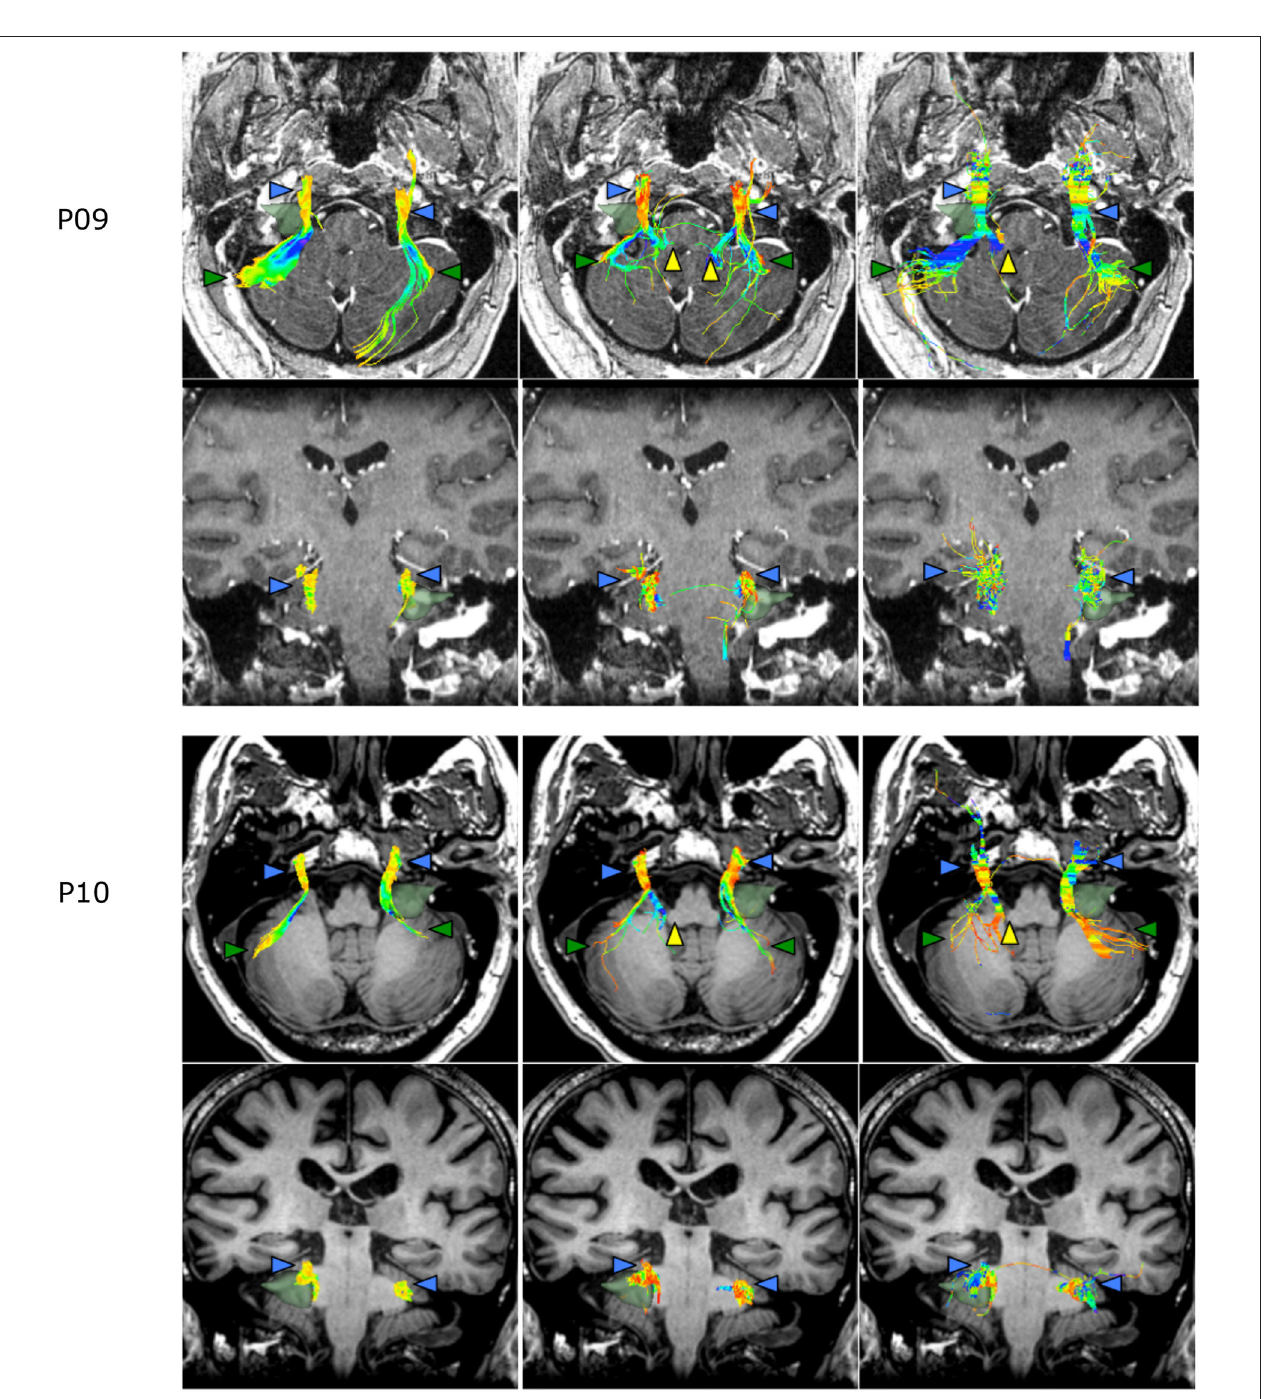
FIGURE 4 | Bilateral CN V generated from each of the three reconstruction methods: Single Diffusion Tensor Tractography (SDT), EXtended Streamline tractography (XST), and streamline tractography on fiber orientation distributions (FODs) derived from constrained spherical deconvolution (CSD) is displayed. Streamlines are displayed overlaid on a T1 anatomical image from a superior and anterior view. Colored triangles indicate particular anatomical landmarks: blue indicates cranial nerves, green indicates superior cerebellar fibers, yellow indicates trigeminal brainstem nuclei. While SDT produced good representations of cisternal segements of CN V (P05–SDT), it was unable to display projections to trigeminal brainstem nuclei (P03–SDT). Both XST and CSD-based tractography could differentiate between superior cerebellar peduncle fibers and trigeminal brainstem nuclei (P03–XST, CSD). SDT also generated aberrant broad projections into the cerebellum when imaging superior cerebellar peduncle fibers (P09–SDT). CSD-based tractography also produced several aberrant fibers when generating superior cerebellar peduncle fibers that encounter trigeminal fibers